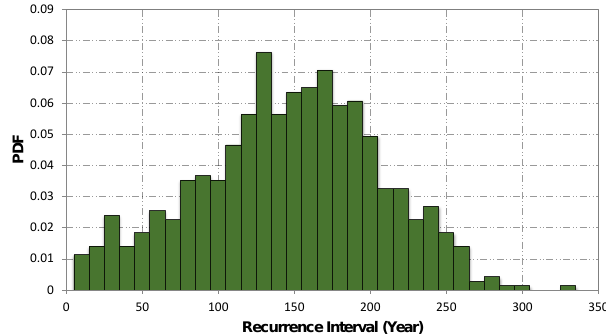
Fig. 5. Probability distribution function (PDF) of earthquake mag- nitudes on the Hayward fault during the 100000yr VC simulation. Bins are 0.1 magnitude units.